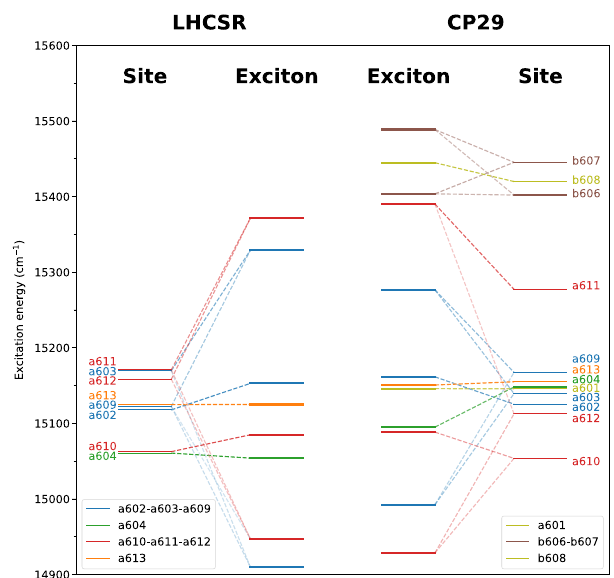
Fig. 5 Exciton structure of LHCSR1 and CP29. Excitation energies of the individual pigments (site) are compared with the exciton states of the whole system. The dashed lines represent the contribution of the site basis to the exciton states and their opacity the magnitude of the contribution. Different colors of the lines represent individual clusters of the strongly interacting chlorophylls. The excited states of LHCSR1 were compared with the ones from CP29. The exciton states were computed from the average Hamiltonian of cluster 4 and single replica for the current model of the LHCSR1 and CP29 respectively. The averaged Hamiltonians and exciton energies for both systems are included in Supplementary Tables 1 – 3.